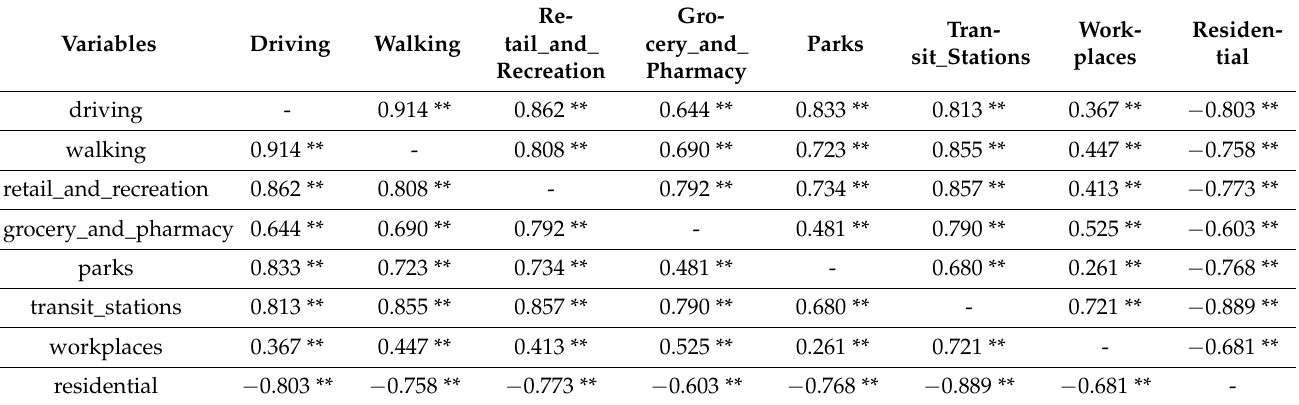
Table A1. Correlations between variables belonging to group Mobility in Poland.